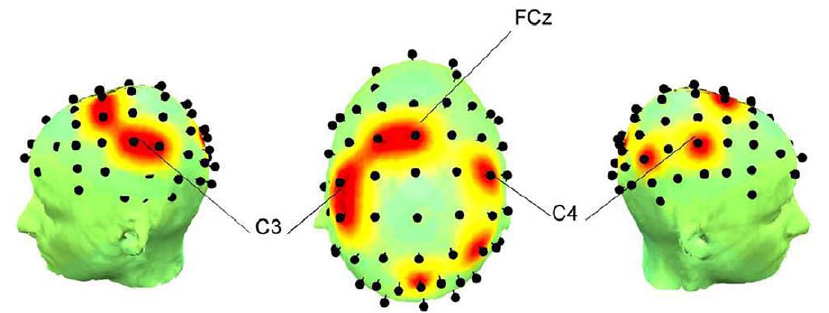
Figure 4. P maps from the left, top and right views. Each point corresponds to the location shown in Table 3, indicating significantly different Enodal , at a cost of 0.28 corresponding to the maximal interaction in Eglob . differences. At FCz channel, the main group effect was found.